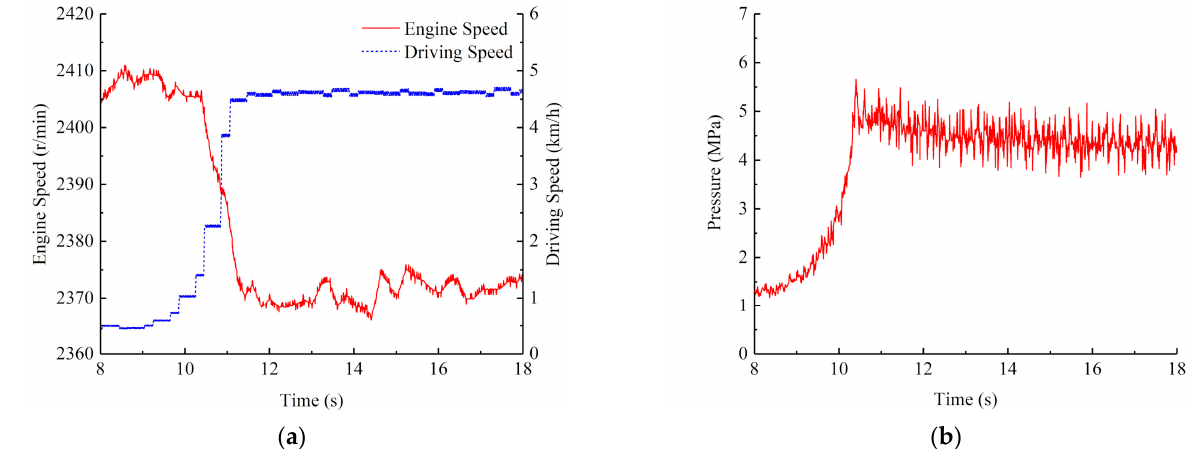
Figure 10. Parameters when starting on flat ground in Gear I: ( a ) change of the engine speed and driving speed; ( b ) change of the inlet and outlet pressure difference of the motor.